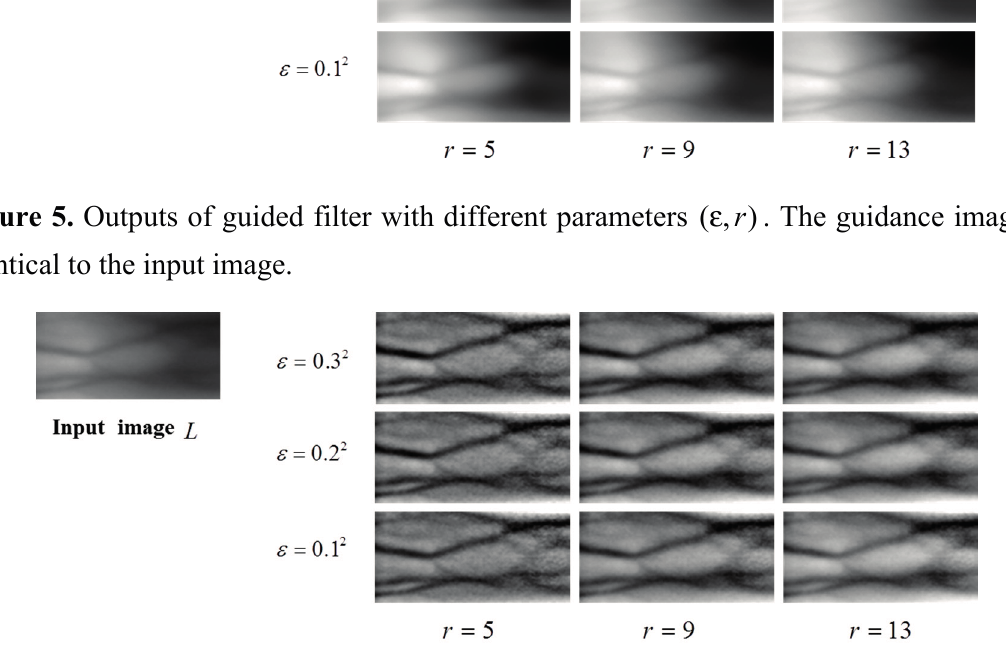
Figure 6. Outputs of IV normalization using GFSSR with the same parameters ( , ) r ε as those in Figure 5.